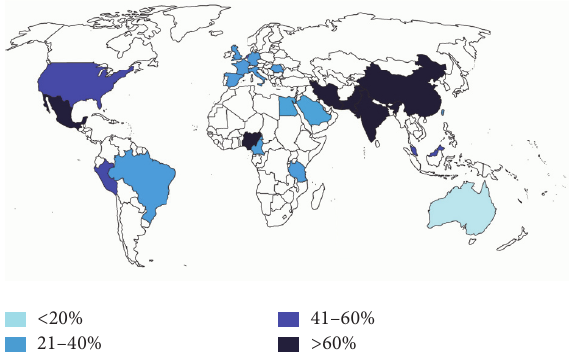
Figure 1: Prevalence of DPN by country. Colors represent the percentiles 25, 50, and 75 of epidemiology